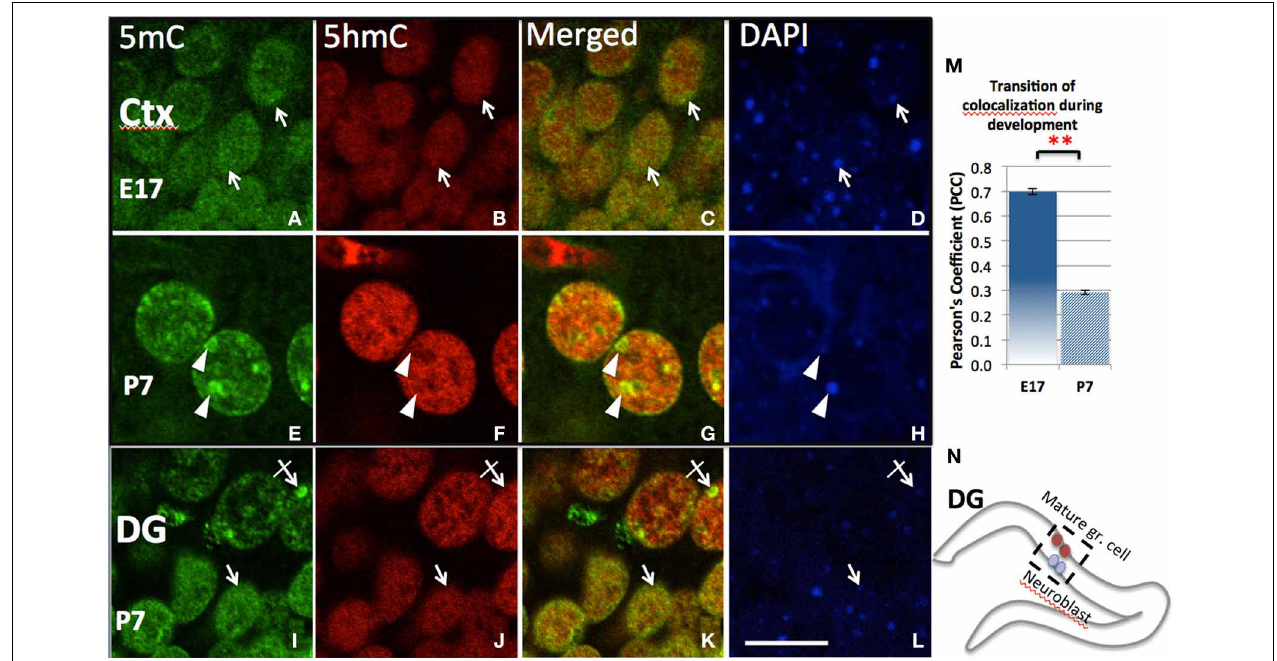
FIGURE 3 | Differential chromatin remodeling of the 5mC (green) and 5hmC (red) during neuroprogenitor cell differentiation. In the developing cortex, both 5mC and 5hmC were diffusely distributed in undifferentiated cells and many were overlapped at E17 ( A–C , D :DAPI. also see quantitation by Pearson’s Coefficient analysis in M ), but polarized into different compartments ( E–G ; arrows) as the neuron differentiated at P7. The 5mC ( E , arrowheads) became associated with DAPI-dense heterochromatic region ( H , arrowheads), while 5hmC in contrast with DAPI-sparse eurchromatic region ( B,F , arrowhead). The dissociation is indicated by decrease of Pearson’s Coefficient between E17 and P 7